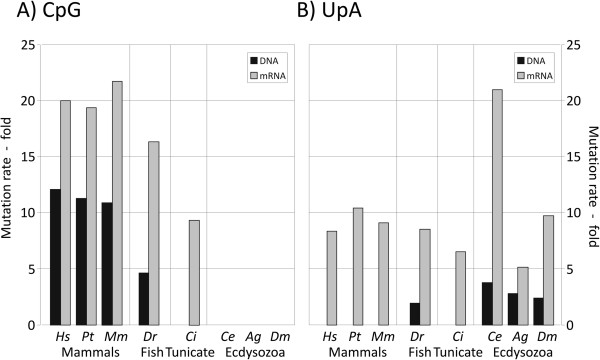
Mutation rates for sequence changes that remove CpG and UpA dinucleotides in different eukaryotes. (A) Rates for mutations removing CpG dinucleotides among the first three parameters for genomic DNA and mRNA sequences of different eukaryotes (B) Mutations removing UpA dinucleotides. Zero values indicate that mutational biases were not detected. Abbreviations: HS: H. sapiens; Pt: P. troglodytes; Mm: Mus musculus; Dr: D. rerio; Ci: C. intestinalis; Ce: C. elegans; Ag: A. gambiae; Dm: D. melanogaster.